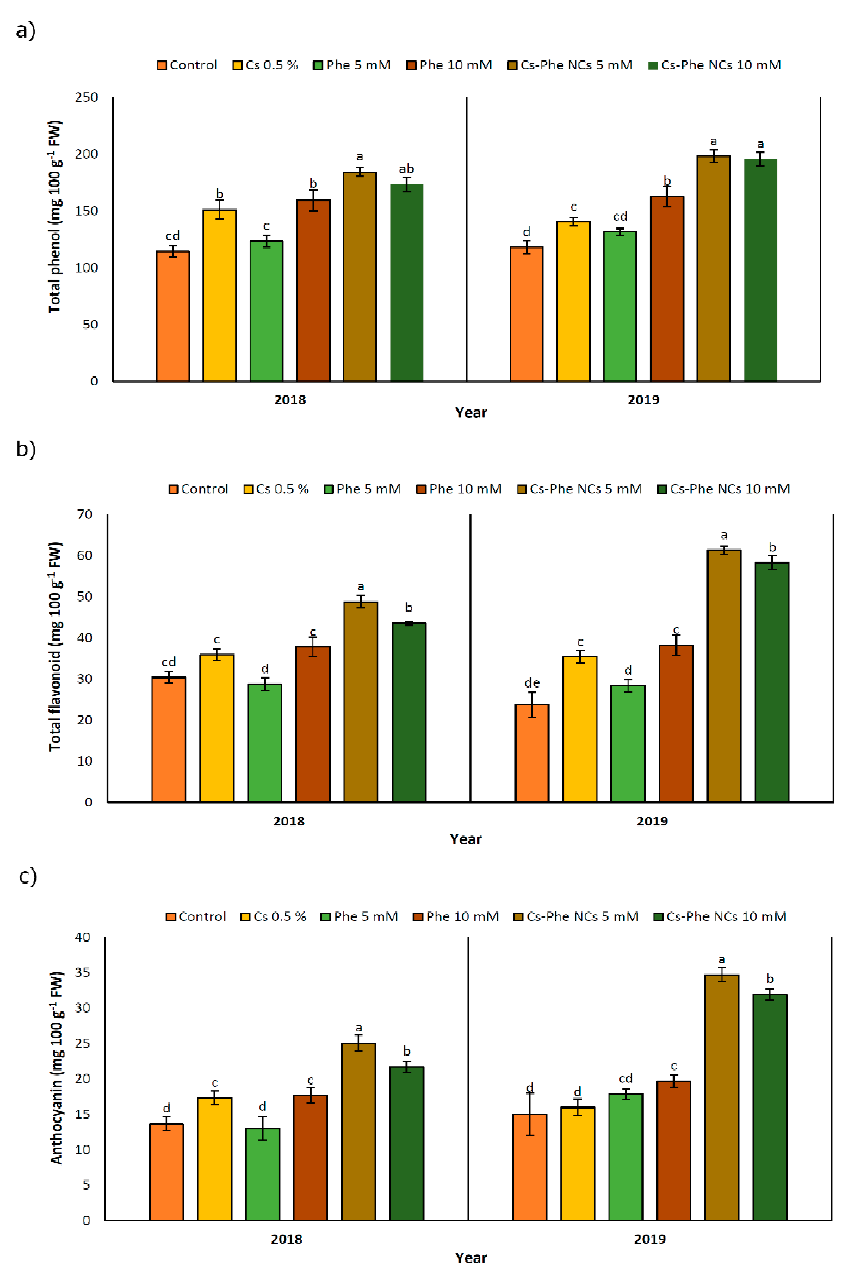
Figure 5. Effect of 0 (control), CS (0.5%), Phe (5 and 10 mM), and CS–Phe NCs (5 and 10 mM) on total phenol ( a ), total flavonoid ( b ), and anthocyanin ( c ) content of V. vinifera cv. Flame Seedless berries. The SDs denoted by lowercase letters in the same treatment indicate significant differences at p < 0.05 according to Duncan’s test.